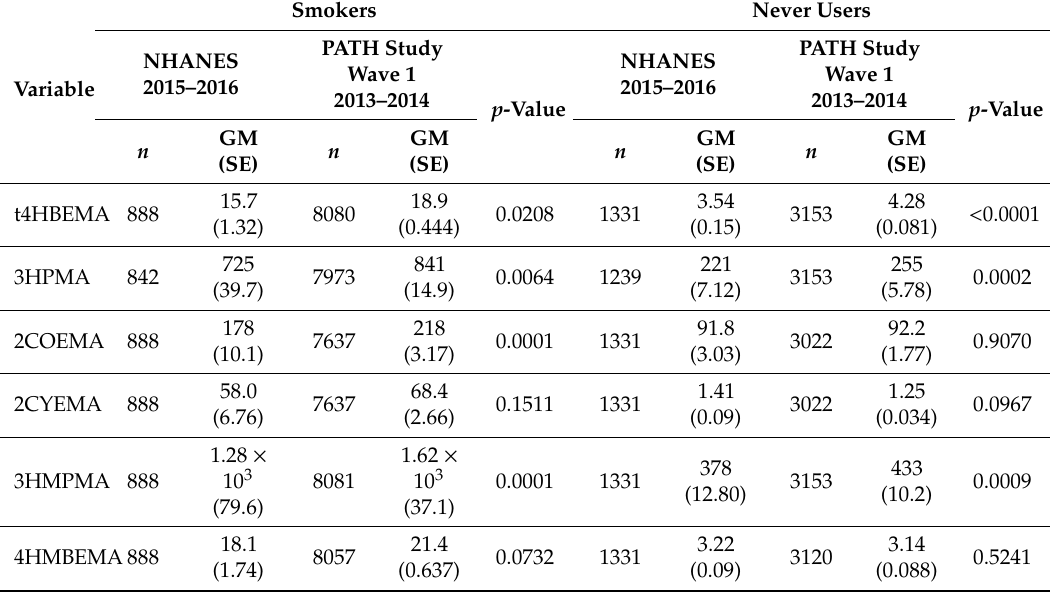
Table 4. Weighted geometric means (GMs, ng / mL) comparisons of six selected VOCMs in the PATH Study Wave 1 and the National Health and Nutrition Examination Survey (NHANES) 2015–2016 data stratified by smokers and never